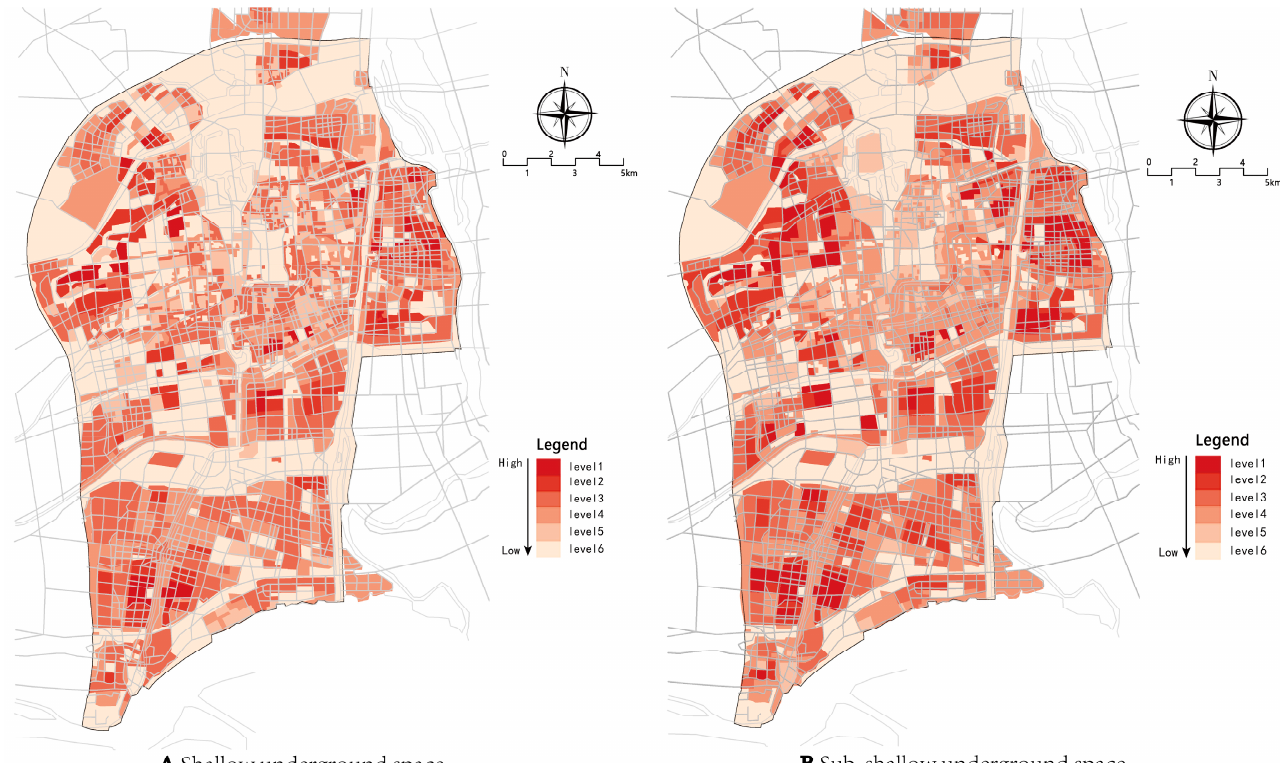
Figure 13. Evaluation results of USR in Yangzhou city.